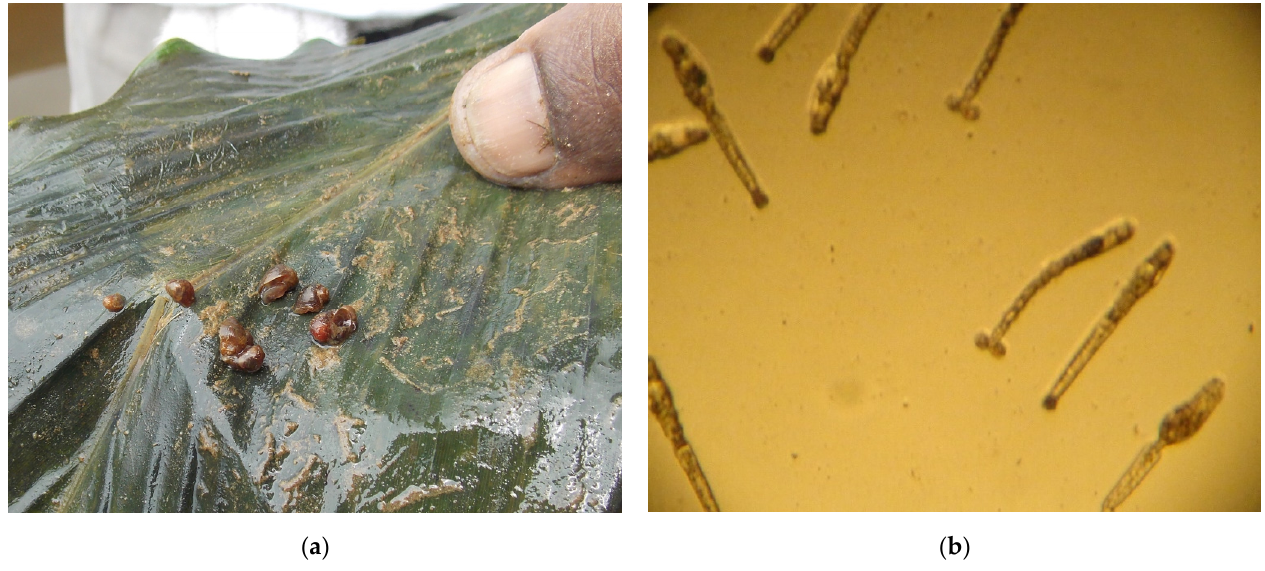
Figure 2. ( a ) Some Bulinus truncatus snails collected at Tsouka village; ( b ) Microscopic view of shedding of some mammalian (forked tail) and Gymnocephalus (single tail) cercariae.